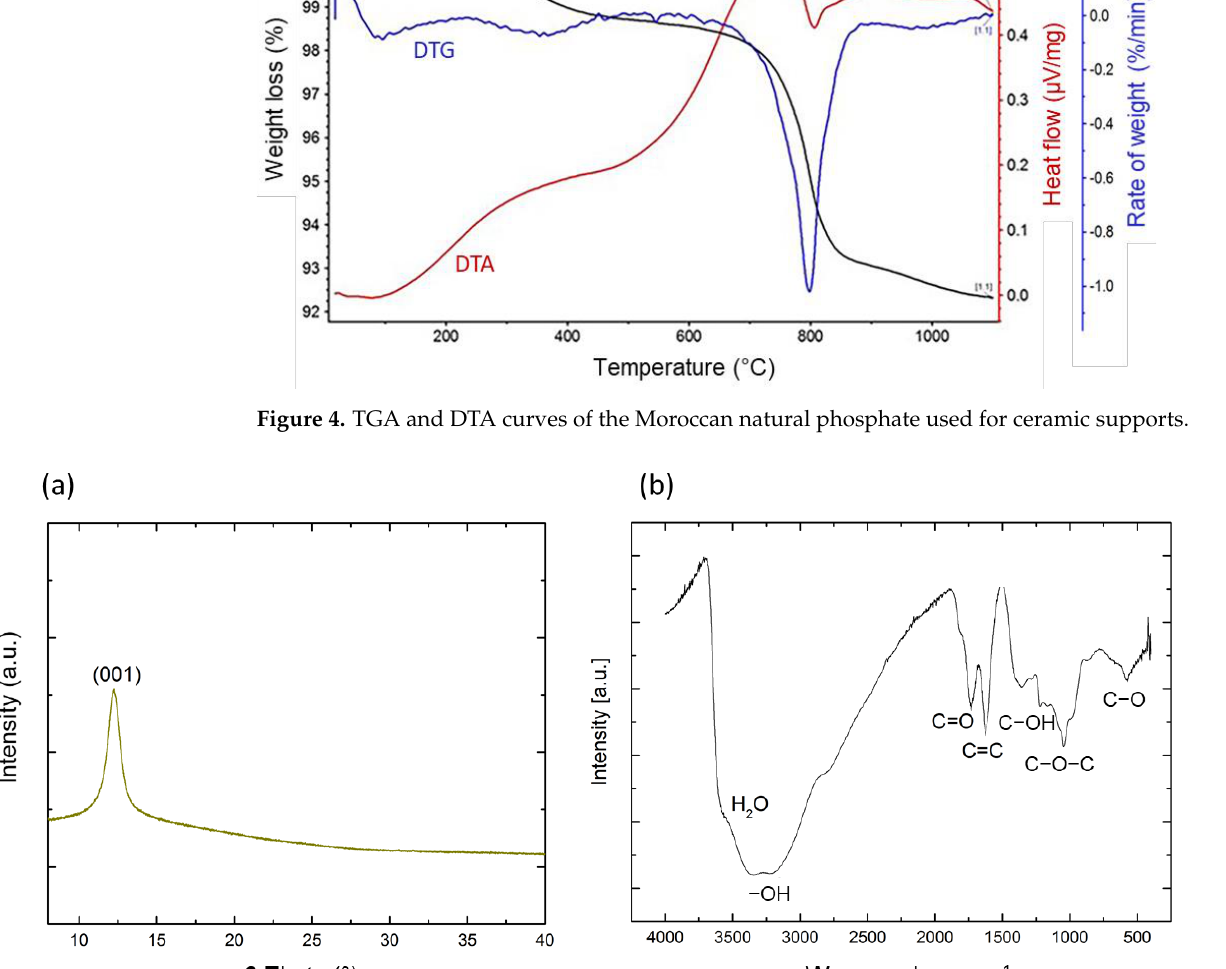
Figure 4. TGA and DTA curves of the Moroccan natural phosphate used for ceramic supports.